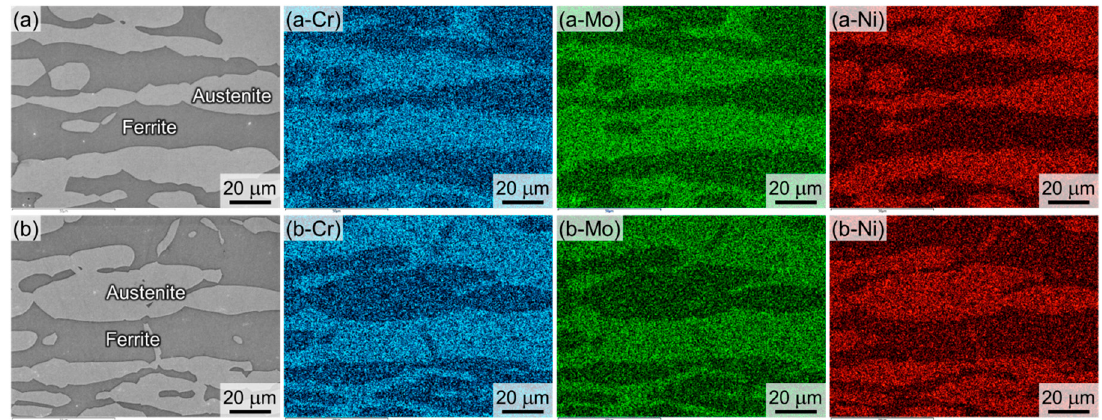
Figure 3. SEM micrographs of the ( a ) DSS-N and ( b ) DSS-NC with EDS maps (Cr, Mo, and Ni).